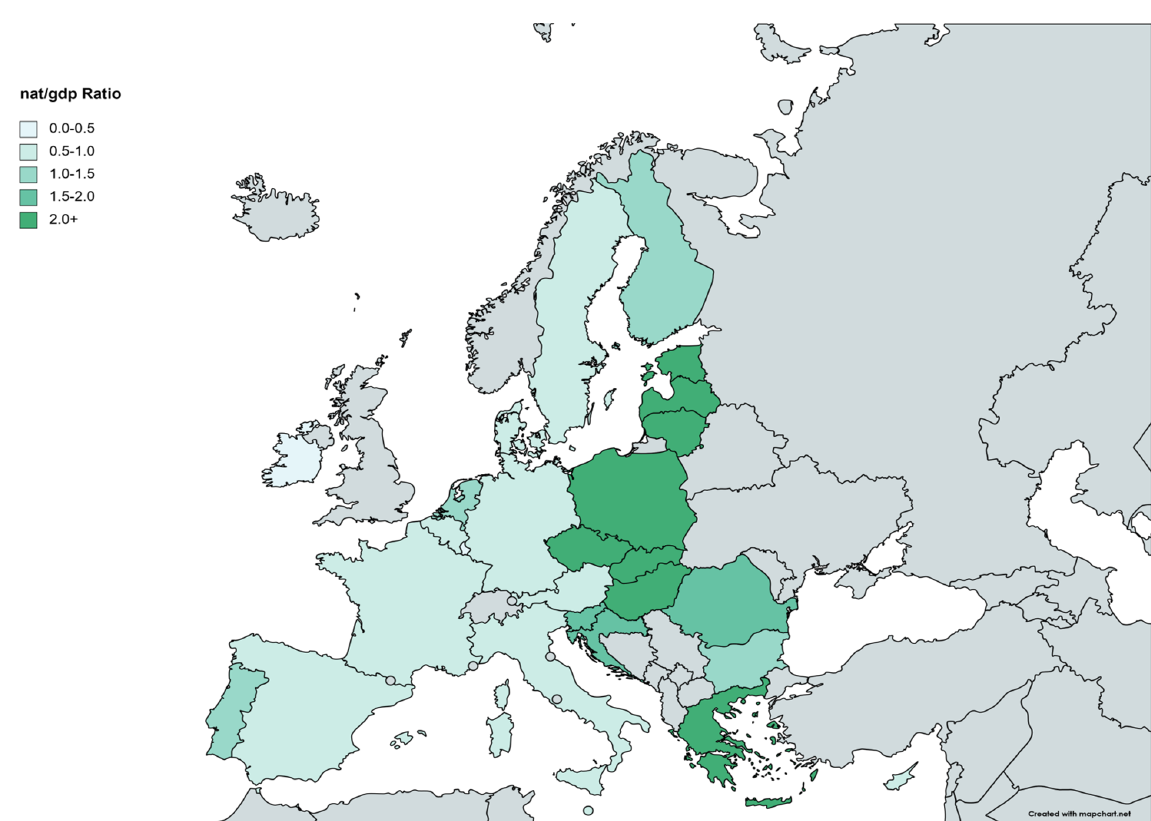
Figure 10. nat/gdp by EU member state.